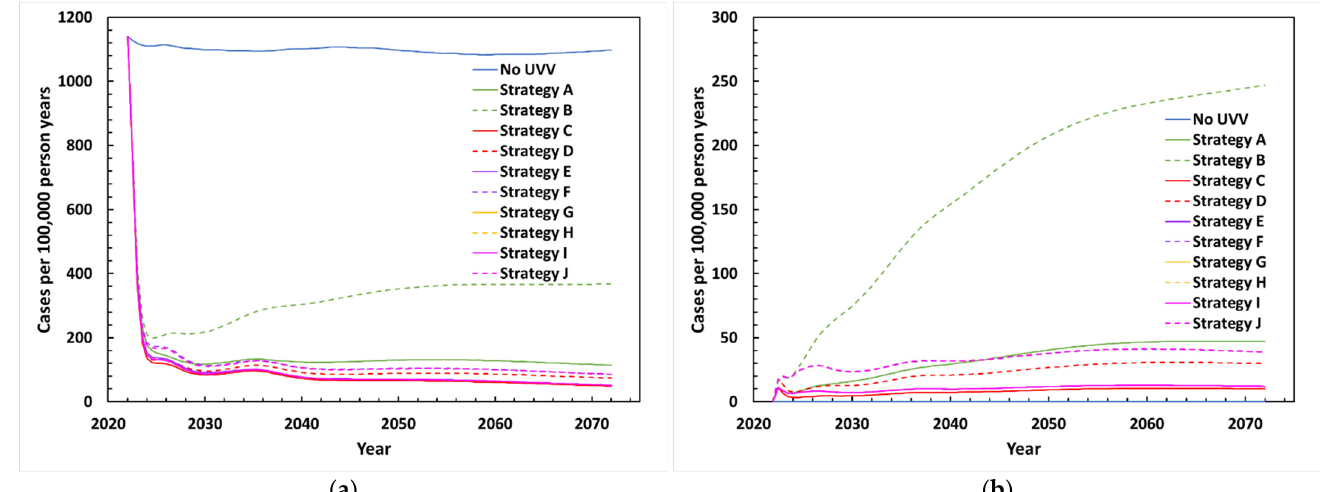
Figure 1. Projected varicella incidence between 2022 and 2072 with various UVV strategies: ( a ) Total varicella cases; ( b ) breakthrough varicella cases. Strategy A : MMRV-MSD (18 months); Strategy B : MMRV-GSK (18 months); Strategy C : V-MSD (12 months, 18 months, catchup); Strategy D : V-GSK (12 months, 18 months, catchup); Strategy E : V-MSD (12 months) + MMRV-MSD (18 months); Strategy F : V-GSK (12 months) + MMRV-GSK (18 months); Strategy G : V-MSD (12 months) +